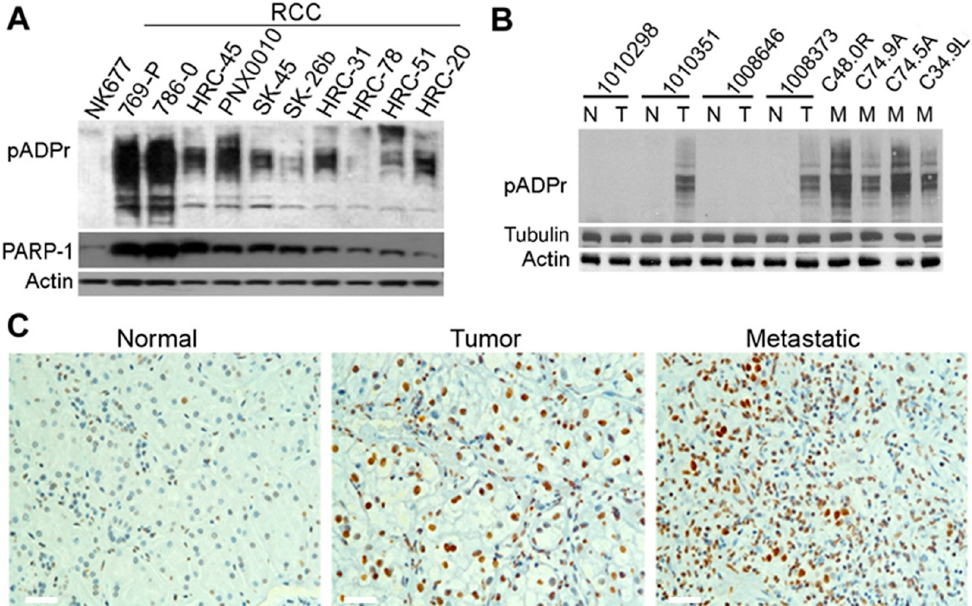
Figure 1. ccRCC cell lines and tumors affected by pADPr turnover. Western blot analysis for pADPr and PARP-1 in ccRCC cell lines ( A ) and patient-derived tumors ( B ). “N,” “T,” and “M” indicate “normal,” “tumor,” and “metastatic” samples, respectively. They were obtained from the same patients and are presented in corresponding order. All studied ccRCC samples demonstrate a high level of pADPr. Actin and Tubulin levels are shown as a loading control. ( C ) Immunohistochemical staining of cryosectioned normal kidney, ccRCC tumor, and metastatic samples from patients reveals significant accumulation of pADPr (brown) in nucleus of tumor and metastatic cells. Representative images are shown. White scale 20 µm. The uncropped Western Blot images can be found in Figure S1.